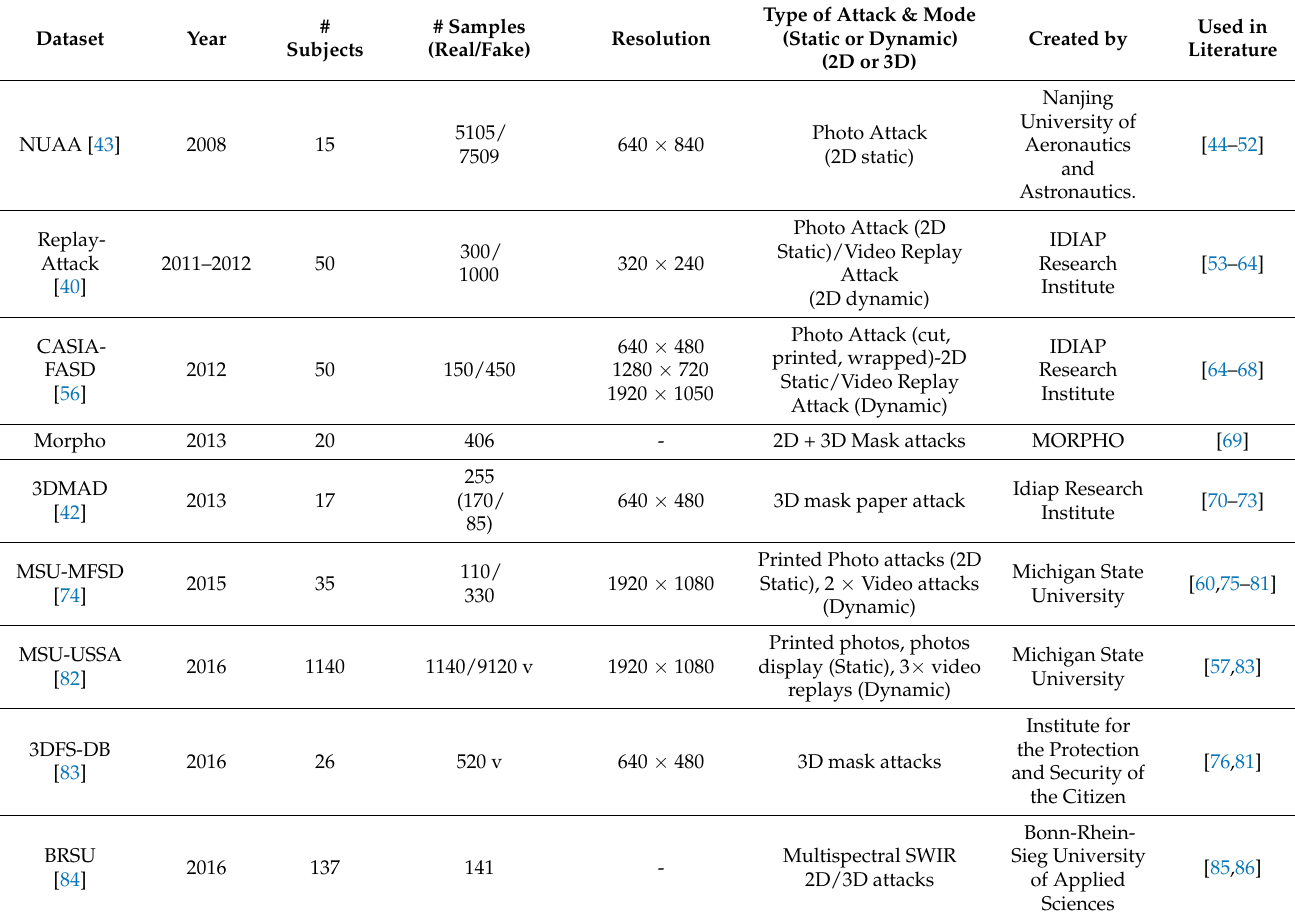
Table 7. 2D & 3D attack Datasets that are publicly available and used in the